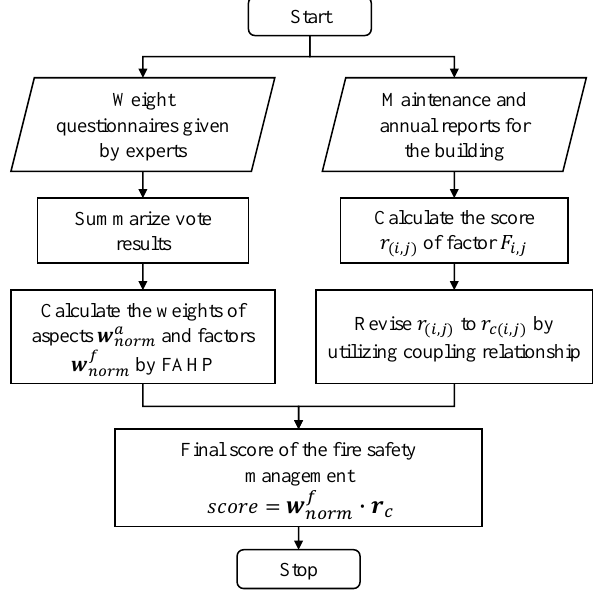
Figure 1. The overall framework for our fire risk assessment approach. Those 18 factors can be summarized into 4 categories: fire control management, facility maintenance, firefighting and rescue, and potential risk inspection. The fire-risk indexing system in our method is listed in Table